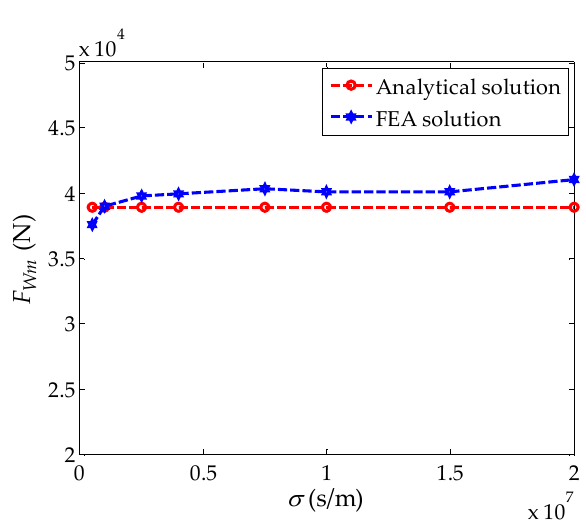
Figure 13. The peak braking force varying with the induction plate conductivity.